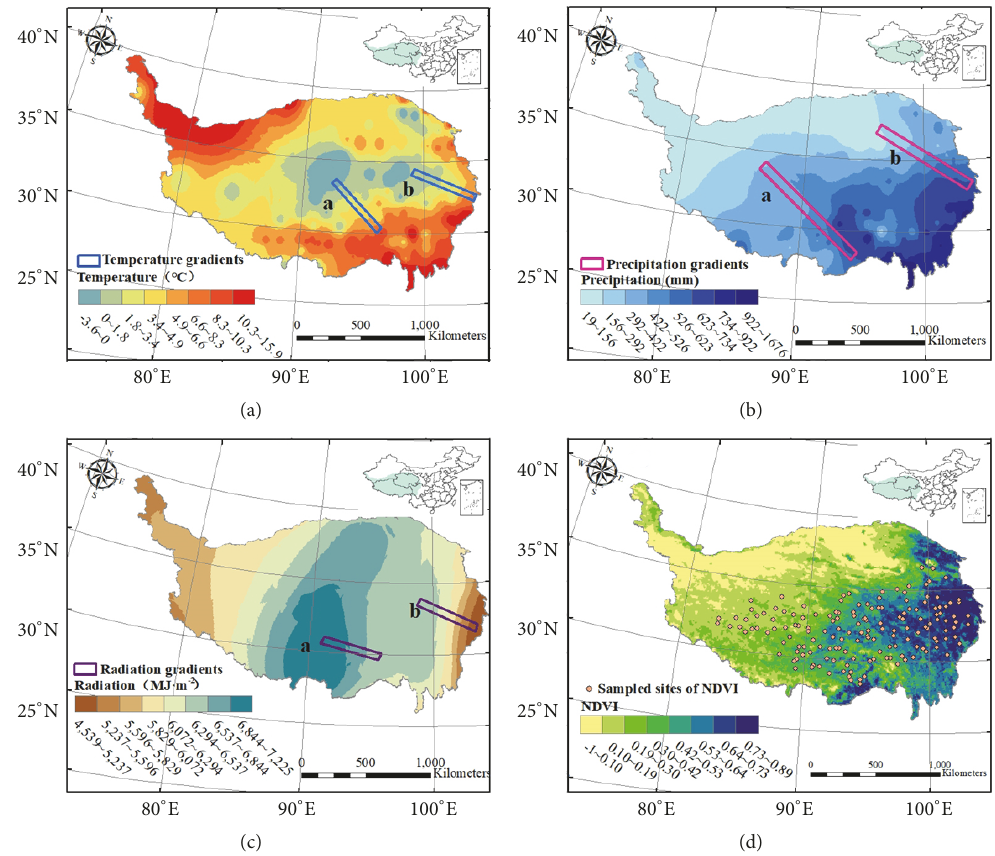
Figure 7: The typical environment gradients of four environmental factors across the Tibetan Plateau. Graphs (a), (b), (c), and (d) represent the gradients of temperature, precipitation, radiation, and NDVI,